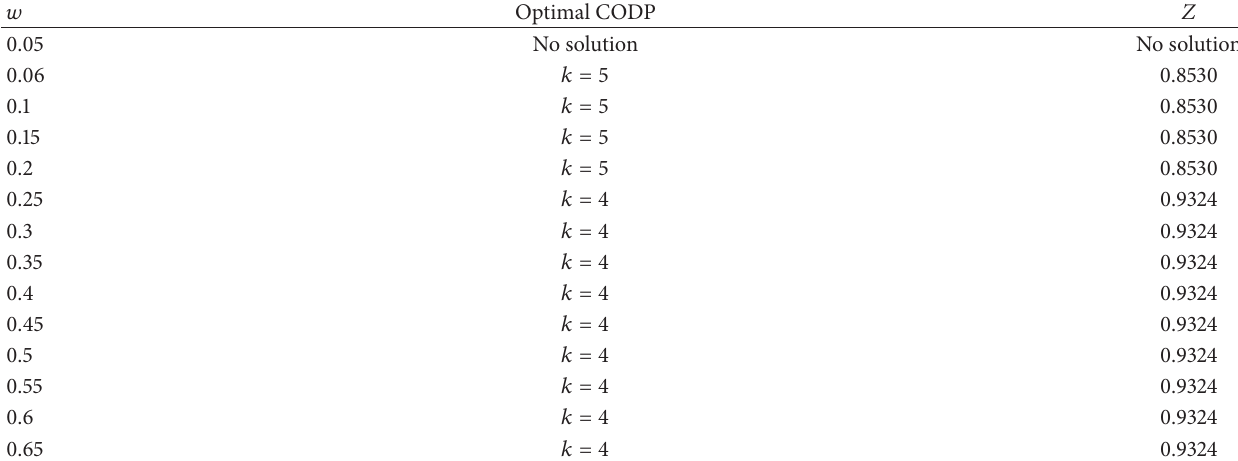
Table 6: 𝑍 varied with 𝑤 .